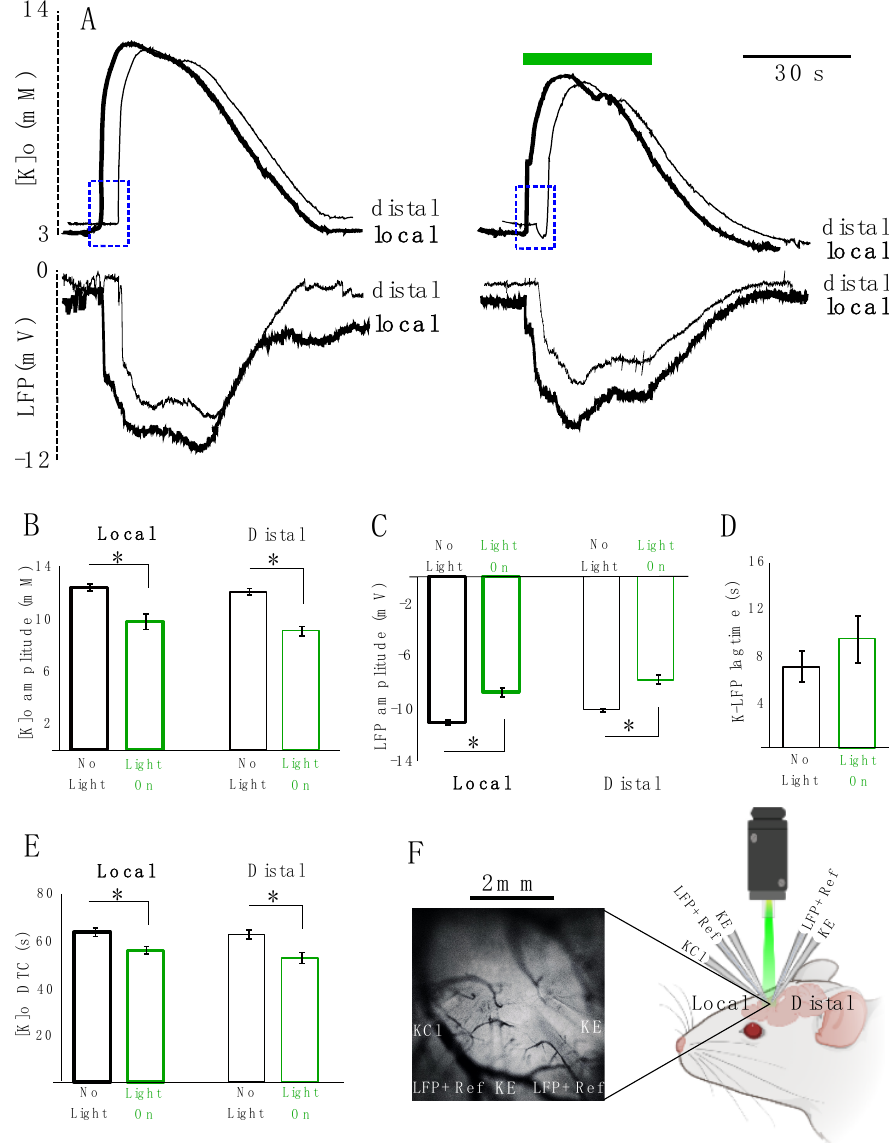
Figure 4. KCl-evoked K responses decreased in amplitude and DTC locally and distally. ( A ) Local and distal coupled K-LFP evoked responses: thick lines represent local responses (in the vicinity of the KCl injection site), thin lines represent distal response (~2 mm away from the injection site). Left: responses in the absence of light. Right: response in the presence of light. Top: [K]o responses. Bottom: LFP responses following KCl injection. ( B ) Summary of local and distal changes in the [K]o amplitude. ( C ) Summary of changes in the LFP amplitude locally and distally. ( D ) summary of changes in the lag time of the K-LFP spreading response traveling from the local to distal site indicated in dotted blue rectangles. ( E ) Summary of changes in the local and distal DTC. Black is in the absence of light and green is when the transfected tissue is exposed to green light illumination. “*’’ represents significance ( p < 0.05). ( F ) Right: experimental configuration: 2 sets of coupled KE-LFP recording electrodes were placed about 2 mm apart from one another, and a KCl injection electrode (KCl) was implanted in the vicinity of one of the KE-LFP electrodes (local site). K-sensitive recording electrode (KE). Local field potential recording electrode along with a local reference electrode for KE (LFP + Ref). Left: in vivo electrodes setting implanted in the transfected area expressing eYFP ( n = 5).